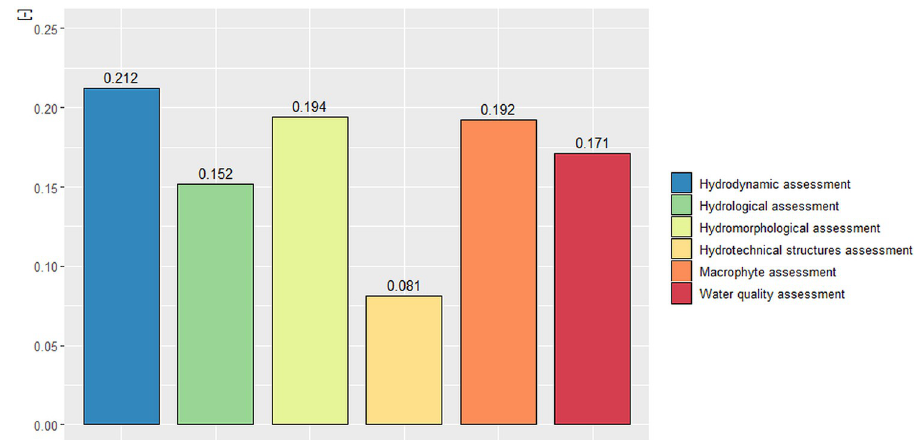
Fig 8. Global vector values for level IV of the hierarchical